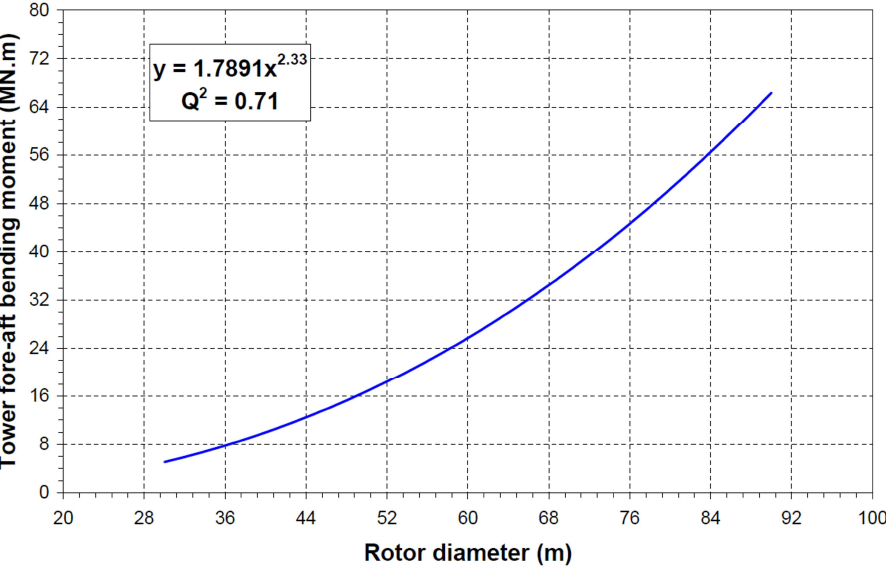
Figure 3. Tower Fore-Aft Bending Moment as a Function of Rotor Diameter, Commercial Data, and Trendline (reprinted from [14], reprint from [13]).